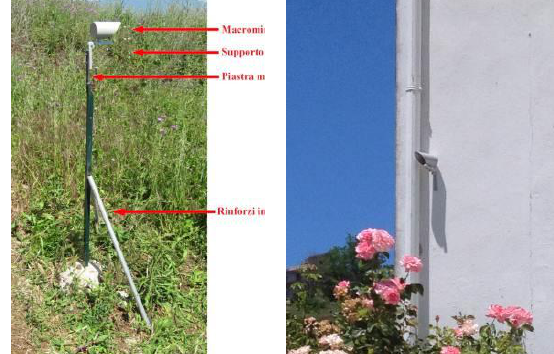
Figure 8.Targets positioned on the landslide crown (left) and on the wall of a building (right)